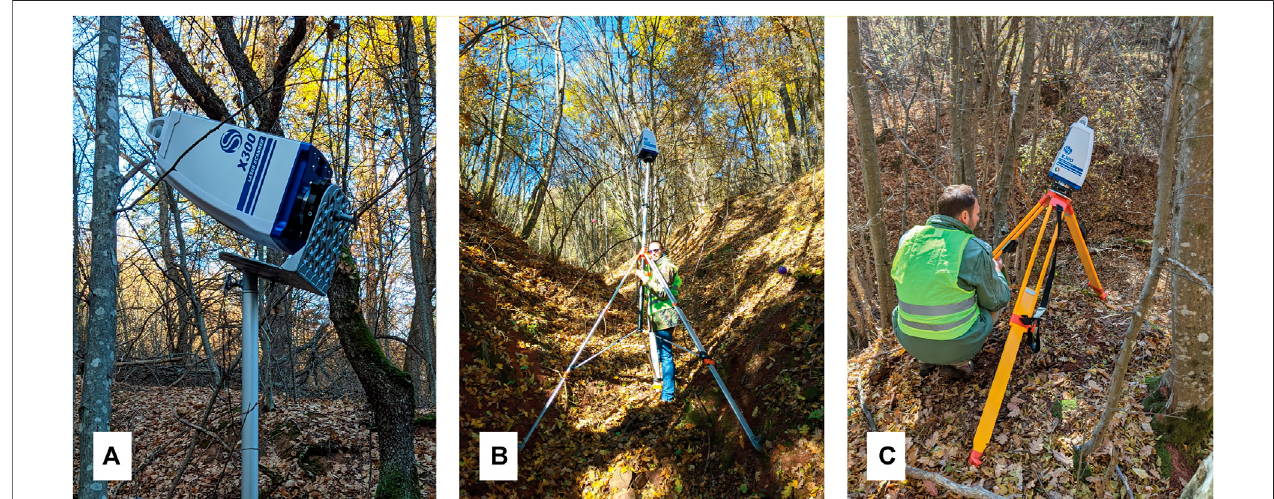
FIGURE 3 | (A) Stonex X300 3D Laser Scanner on the special custom-made holder, (B) scanning at the bottom and (C) from the edge of the gully.